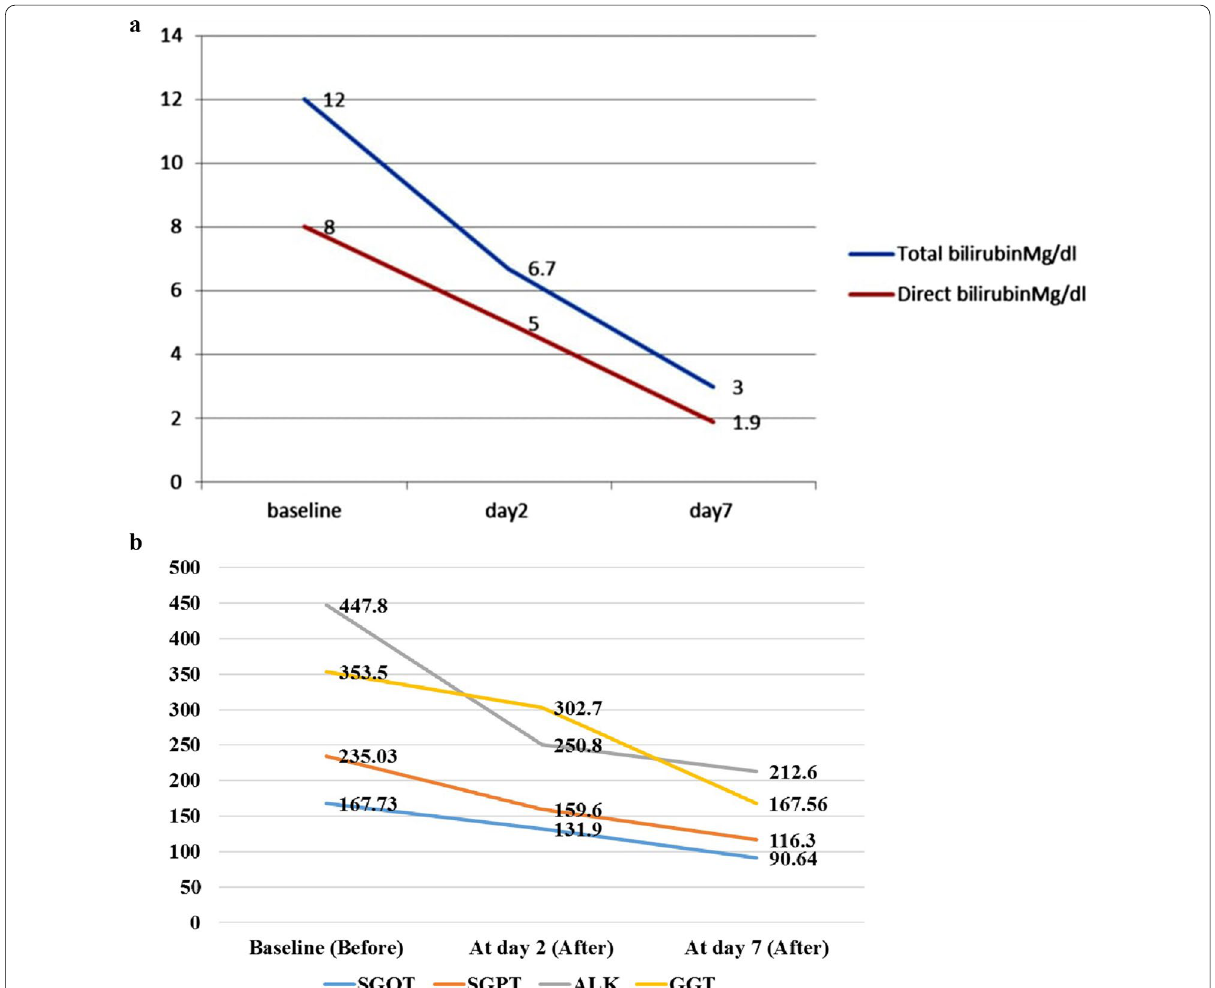
Fig. 2 Changes in the laboratory data over baseline (day 0), (day 2) and (day 7), including a bilirubin levels and b liver enzymes (SGOT, SGPT) as well as ALK and